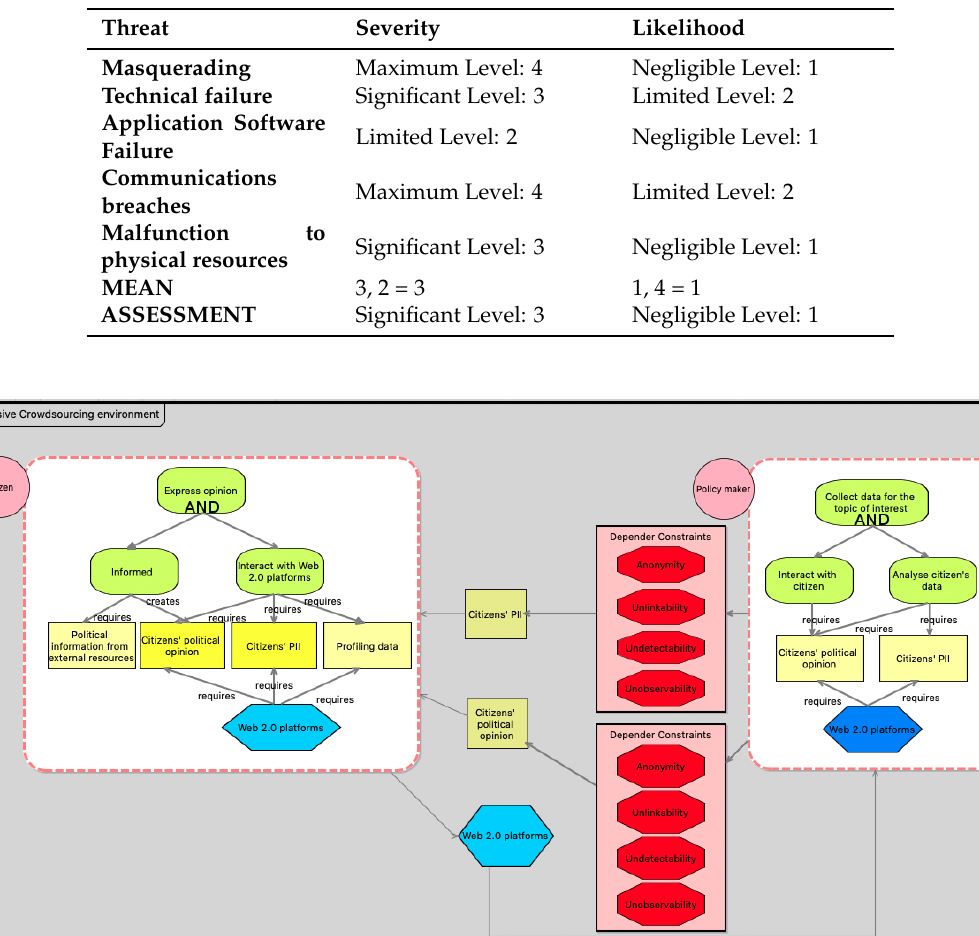
Table 4. Risk category: Data disappearance.